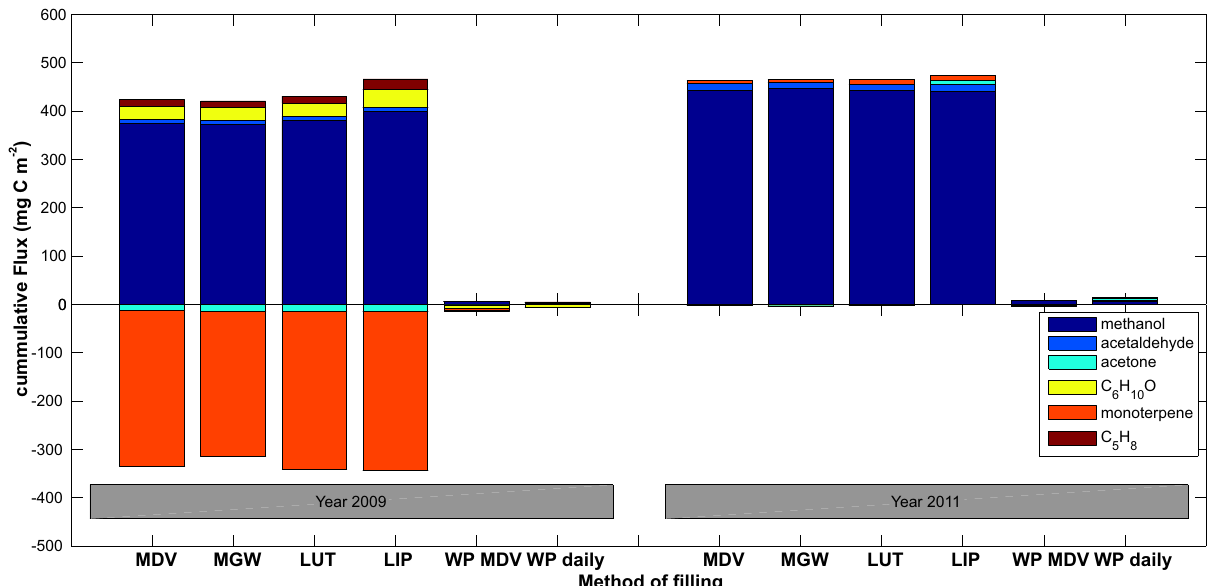
Fig. 2. Bar graph of the cumulative carbon fluxes of the different VOCs (methanol (dark blue), acetaldehyde (blue), acetone (cyan), m/z 99 (yellow), monoterpenes (red) and m/z 69 (brown)) obtained by application of the four different gap-filling methods (MDV, MGW, LUT, LIP) for the years 2009 and 2011. The cumulative fluxes for the winter period calculated after gap-filling the complete number of missing winter measurement days on a half-hourly basis using median diurnal cycles (WP MDV) and on a daily basis using median daily values (WP daily), which were obtained from the measurements during days with snow cover (2009 and 2011), are shown as additional